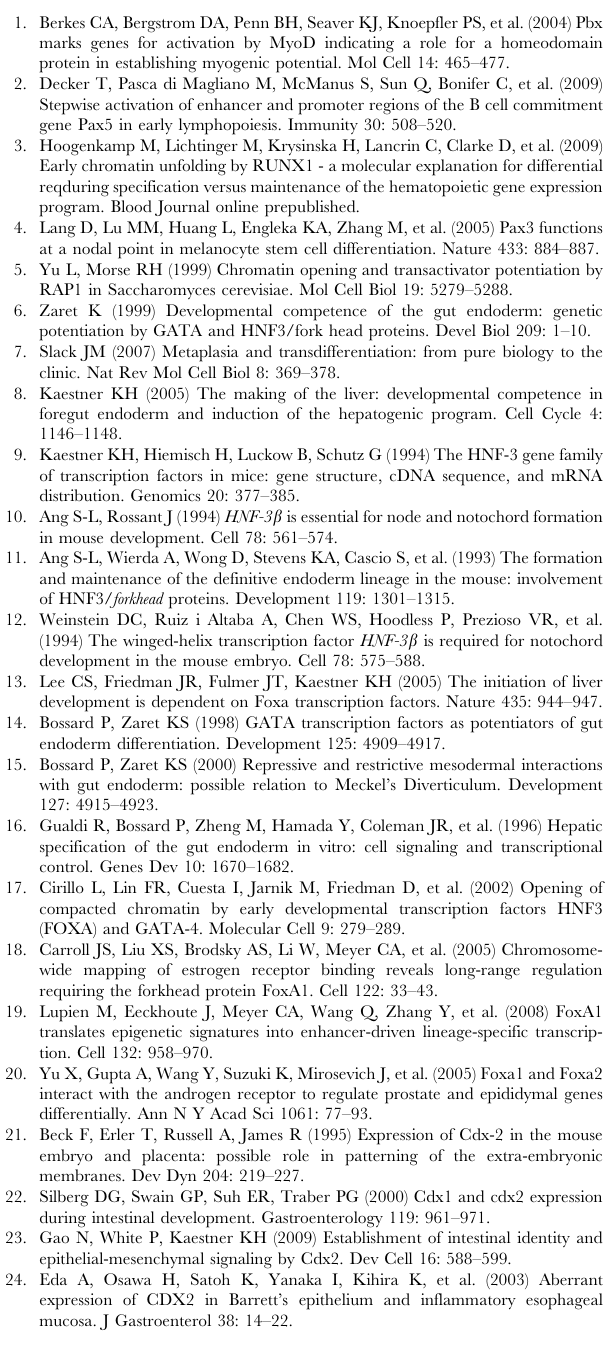
Table S2 Liver FoxA Binding Sites. Table S3 Primers for ChIP-qPCR. Table S4 Taqman Probe